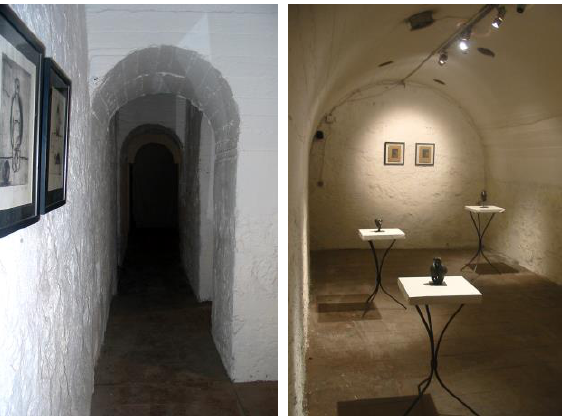
Figure 8. Interior of Rewaq al-Qeshla, R.Aboukhater, May 2010.